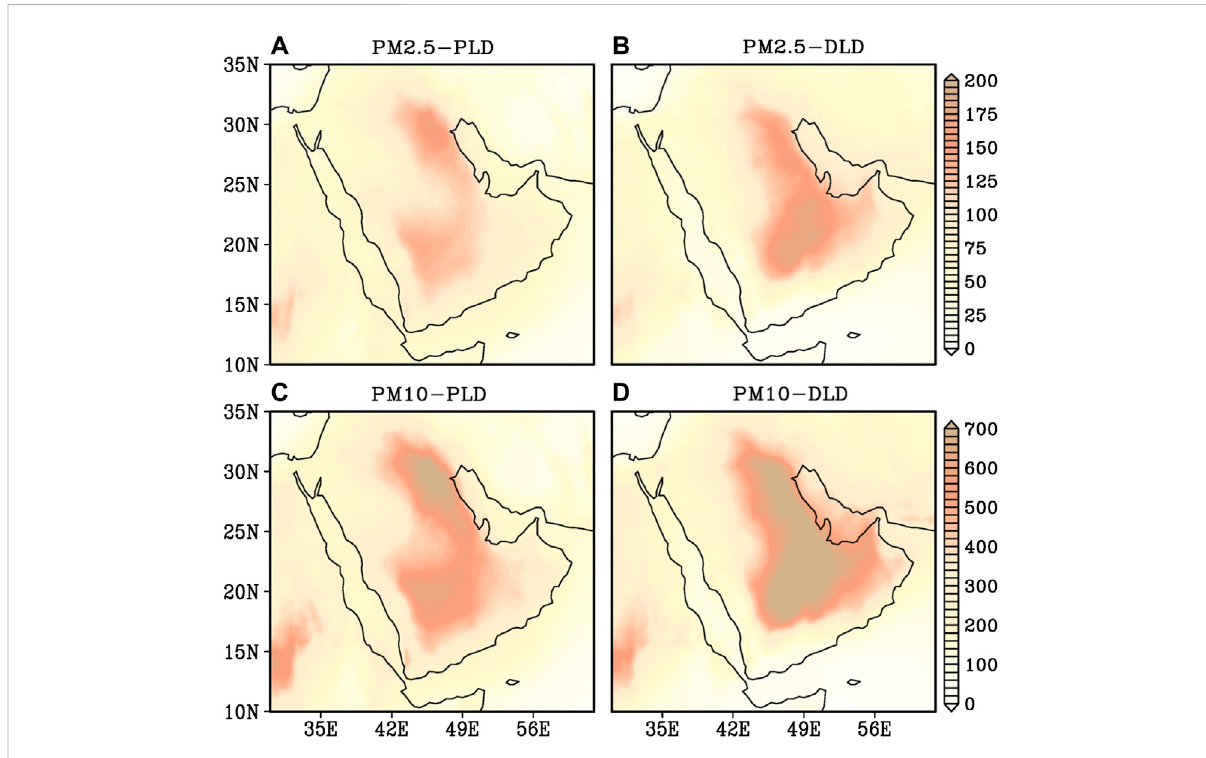
FIGURE 6 Time averaged spatial distributions of PM 2.5 and PM 10 during PLD and DLD periods as simulated by